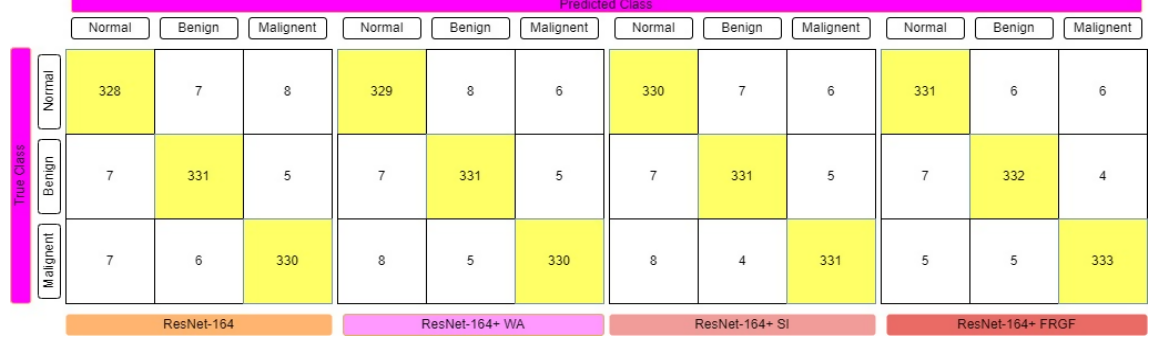
Figure 9. Confusion matrix representation of ResNet-164 deep CNN model with various fuzzy ensemble technologies. ResNet-164, ResNet-164+ WA, ResNet-164+ SI, and ResNet-164+ FRGF showed 96.11%, 96.21%, 96.40%, and 96.79% of accuracy, respectively.